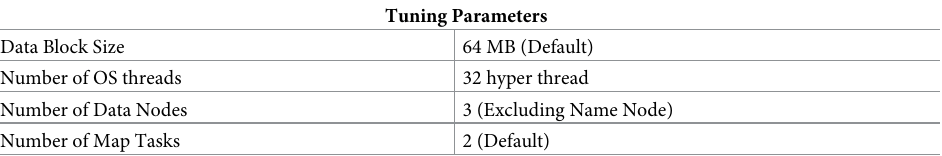
Table 5. Tuning parameters for bottleneck analysis.